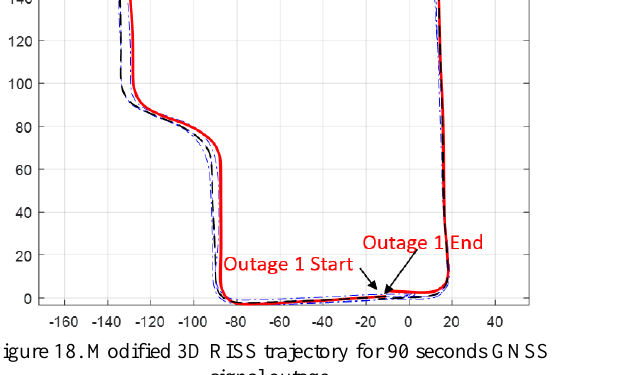
Figure 20. INS standalone trajectory for 90 seconds GNSS signal outage